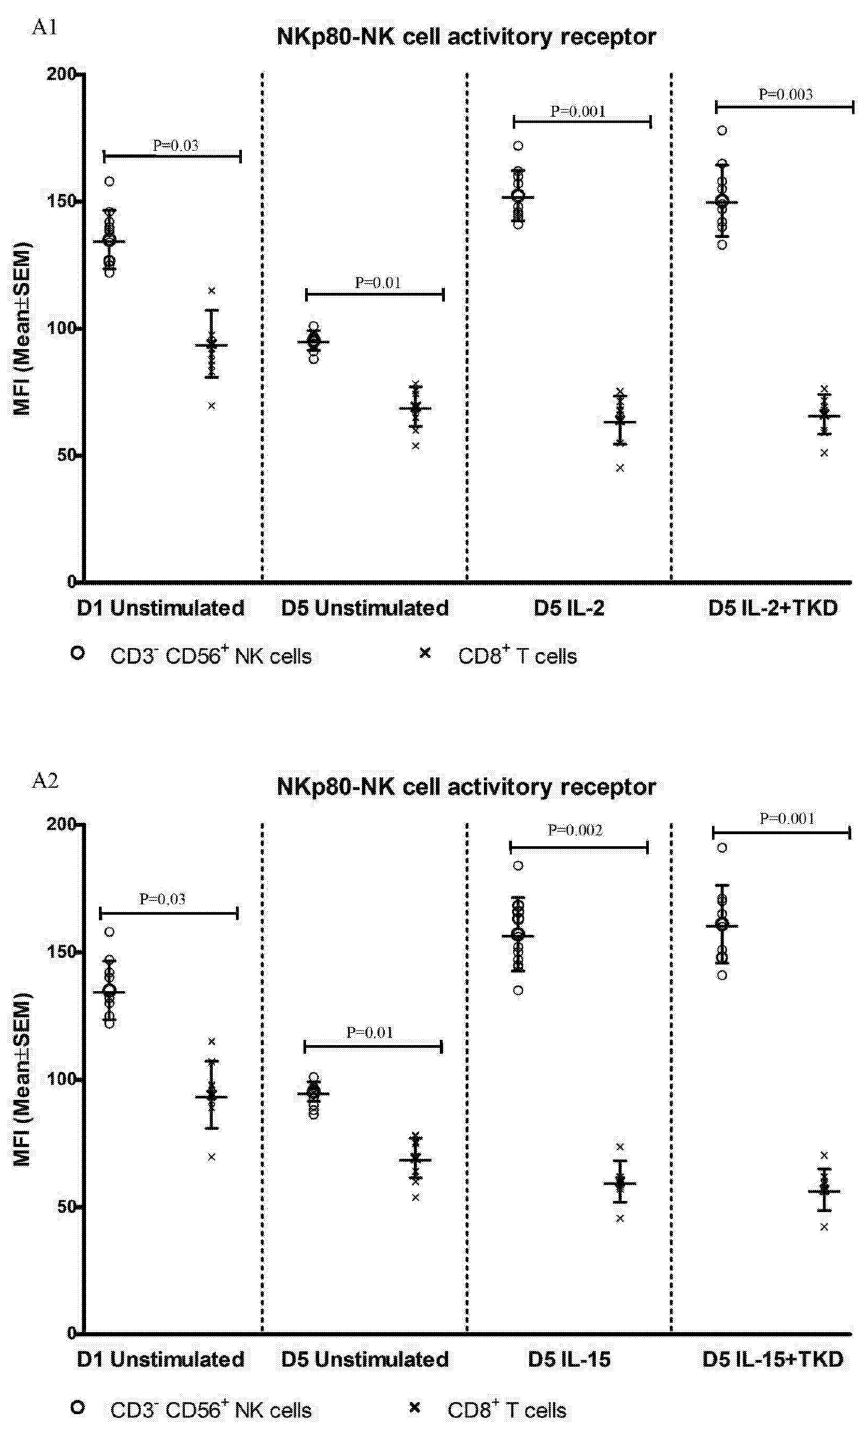
Fig 16. The effect of IL-2, IL-15, IL-2/TKD and IL-15/TKD on the expression of NKp80 in peripheral blood mononuclear cells of healthy individuals — the amount of receptor expressed by CD3 - CD56 + NK cells and CD8 + T cells (the median fluorescence intensity). The amount of NKp80 expressed by CD3 - CD56 + NK cells and CD8 + T cells was examined within the fraction of unstimulated and stimulated mononuclear cells derived from 10 healthy individuals. Data are presented as means ± standard error. In total, the study cohort consisted of 52 Caucasian healthy individuals.